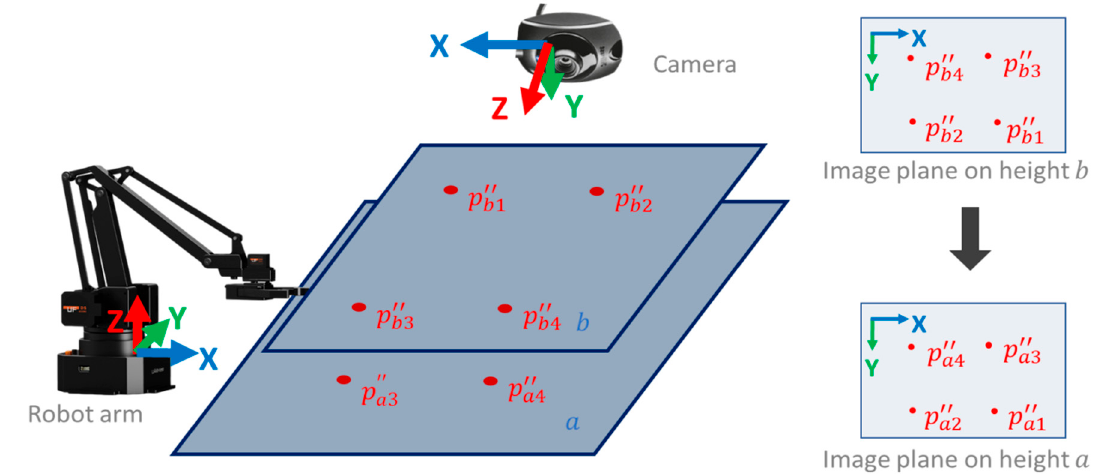
Figure 10. Diagram of the fine-tuned height.